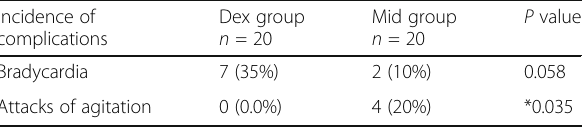
Table 4 Comparison of the incidence of complications between the study group Incidence of